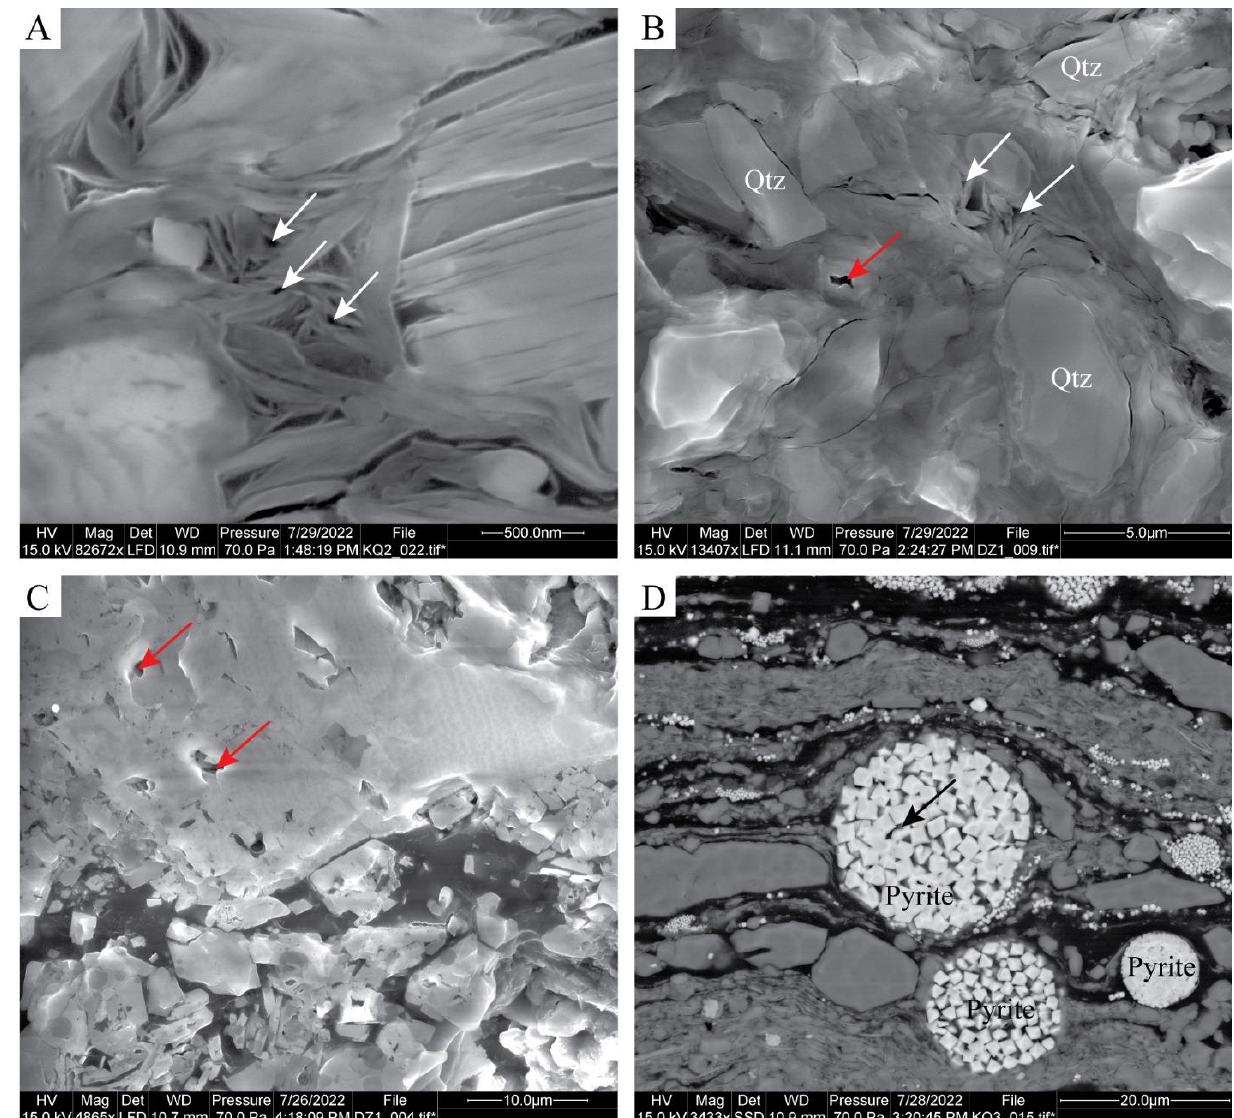
Figure 8. SEM images showing mineral-associated pores in the studied Chang 7 Member shale samples. ( A ) Phyllosilicate framework pores (white arrows). Sample KQ-2. ( B ) Phyllosilicate framework pores (white arrows) and dissolution pores (red arrows). Sample DZ-1. ( C ) Dissolution pores (red arrows). Sample DZ-1. ( D ) Pores within pyrite framboids (black arrows). Sample KQ-3. Qtz = quartz.